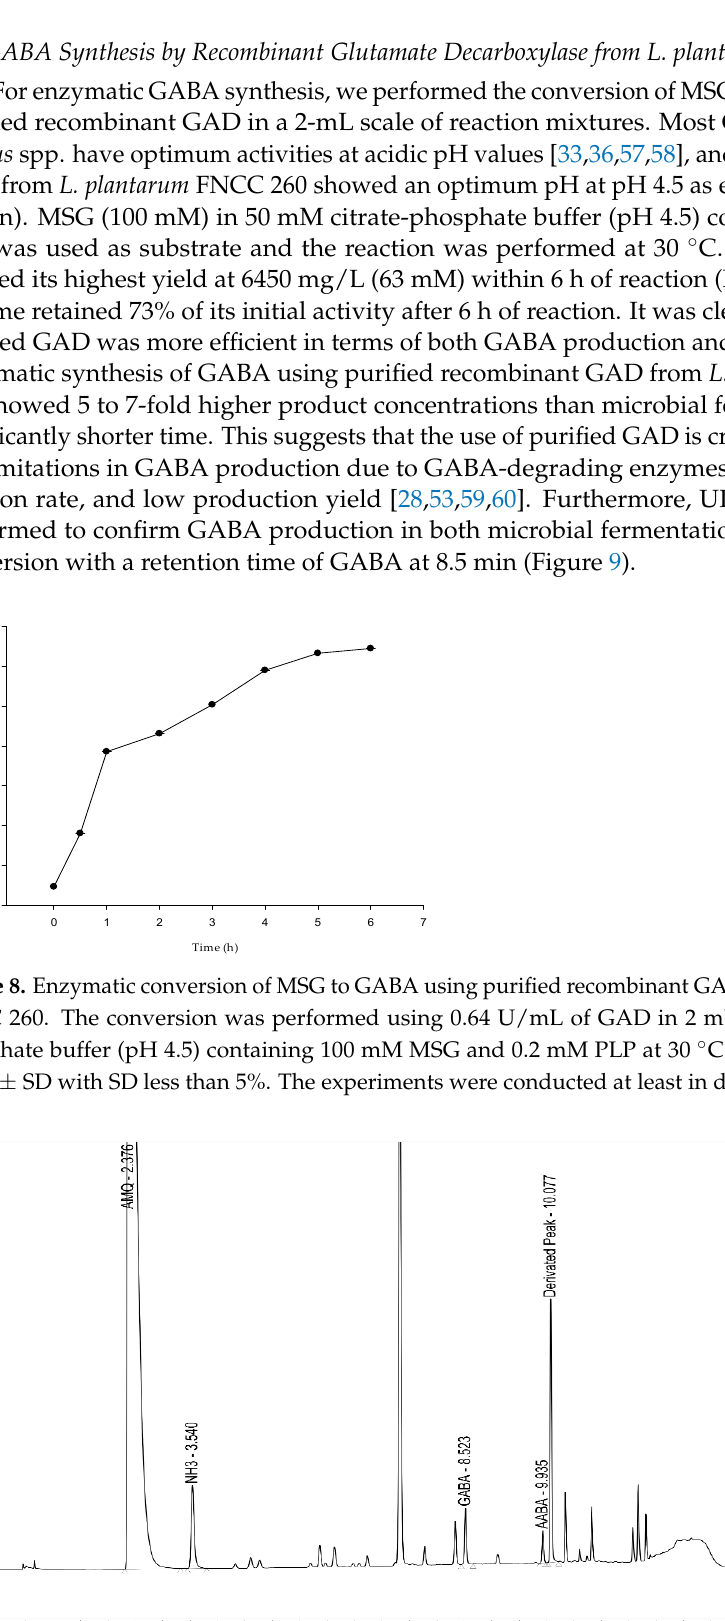
Figure 7. Alignment of amino acid sequences of GAD from L. plantarum FNCC 260 and six other GADs from LAB. The consensus sequence HVDAASGGF indicated by a smaller red box is highly conserved in GAD sequences. The sequence SINASGHKYGLVYPGVGWVVWR in the bigger red box is the PLP-binding domain [49]. GadB sequences shown are from L. delbrueckii (Ldelbrueckii),